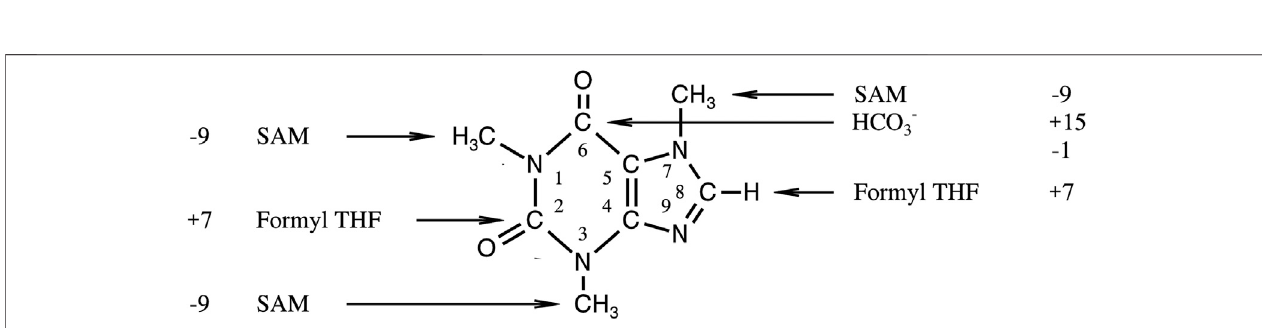
FIGURE 3 | Origin of different positions in caffeine and their difference in [ ‰ (mUr)] PDB to the mean δ 13 C-value of whole the molecule (see 22).